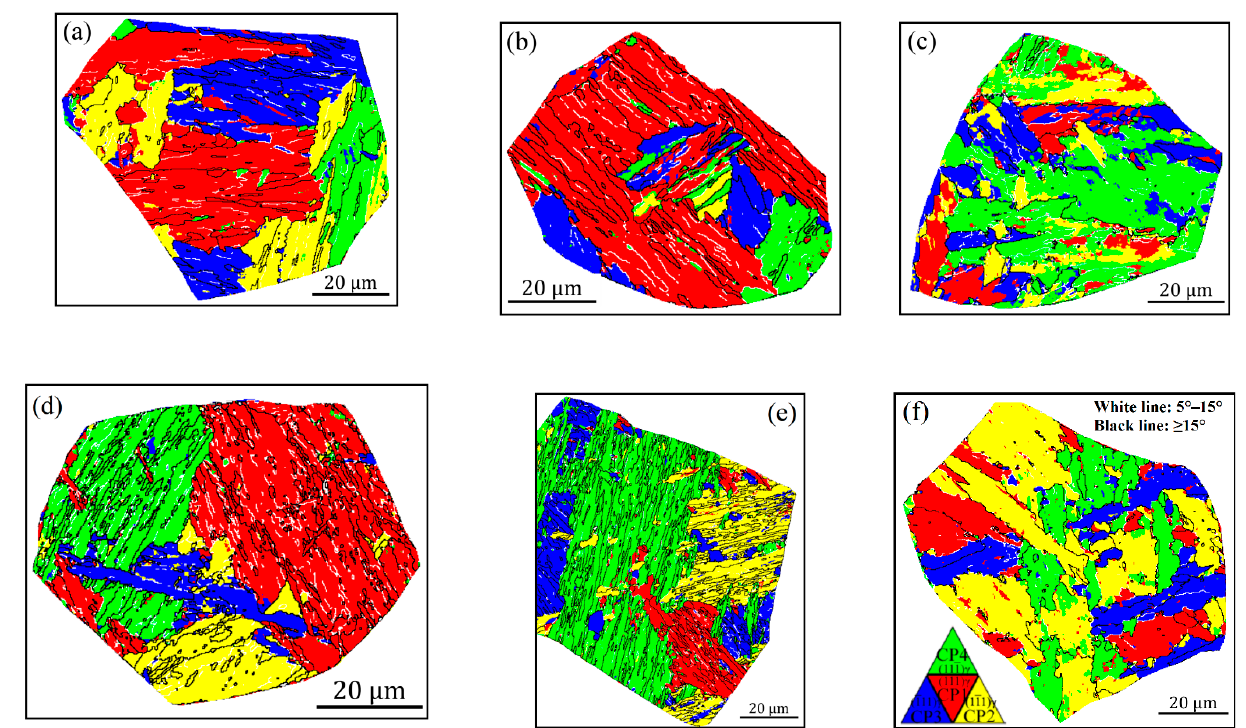
Figure 6. Reconstructed crystallographic packets of the simulated samples with 0.04 wt.% C ( a – c ) and 0.12 wt.% C ( d – f ) under the different heat inputs: ( a , d ) 10 kJ/cm, ( b , e ) 20 kJ/cm and ( e , f ) 50 kJ/cm.